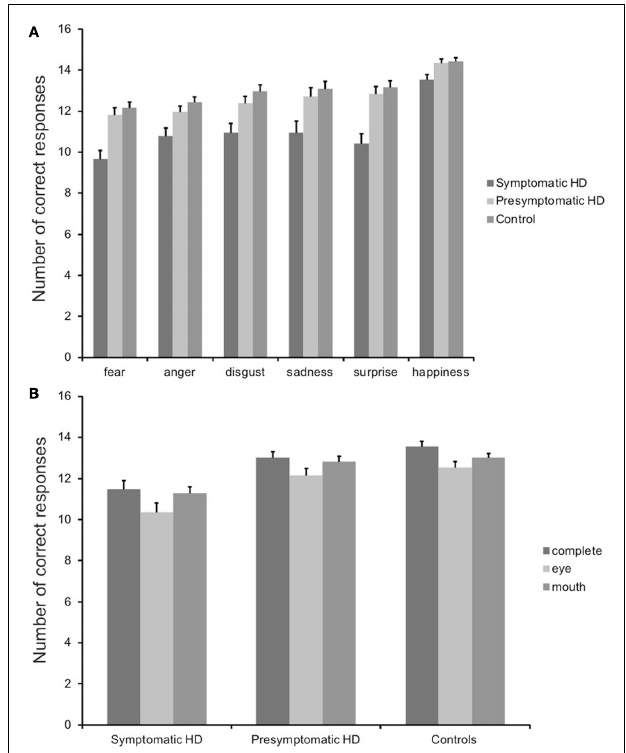
FIGURE 4 | Results of the forced-choice emotion recognition task. (A) Number of correct responses (SE) separated for the three groups and the six emotions; (B) Number of correct responses (SE) separated for the three groups and the three task conditions.